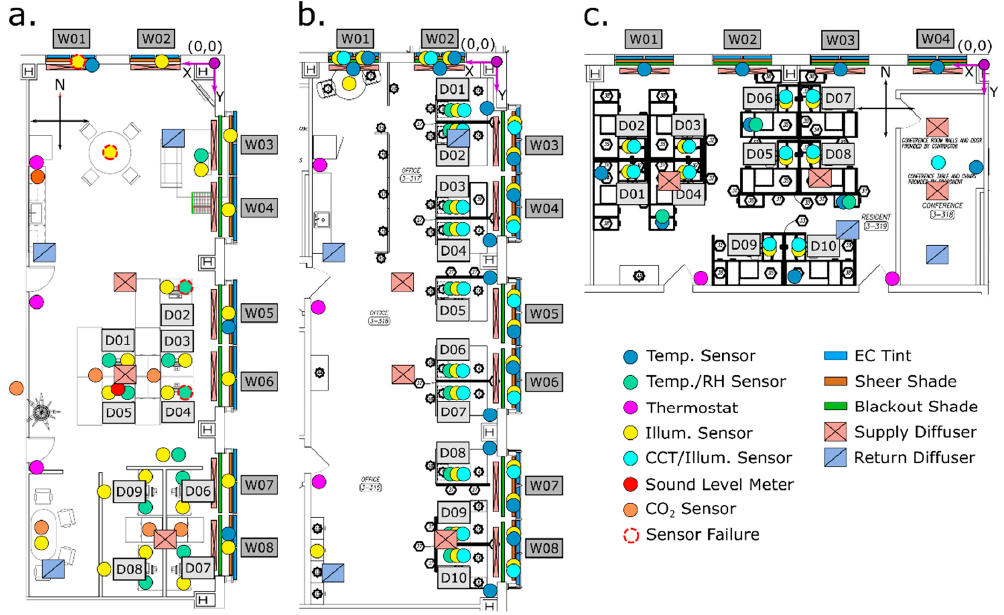
Figure 1. Office layouts and sensor deployment maps for the ( a ) multi-IEQ (indoor environmental quality) study, ( b ) daylighting study, and ( c ) electric lighting study (D## represent desk numbers and W## represent window numbers). Note the x- and y-axes per office are later used in spatial assessments and plotting.